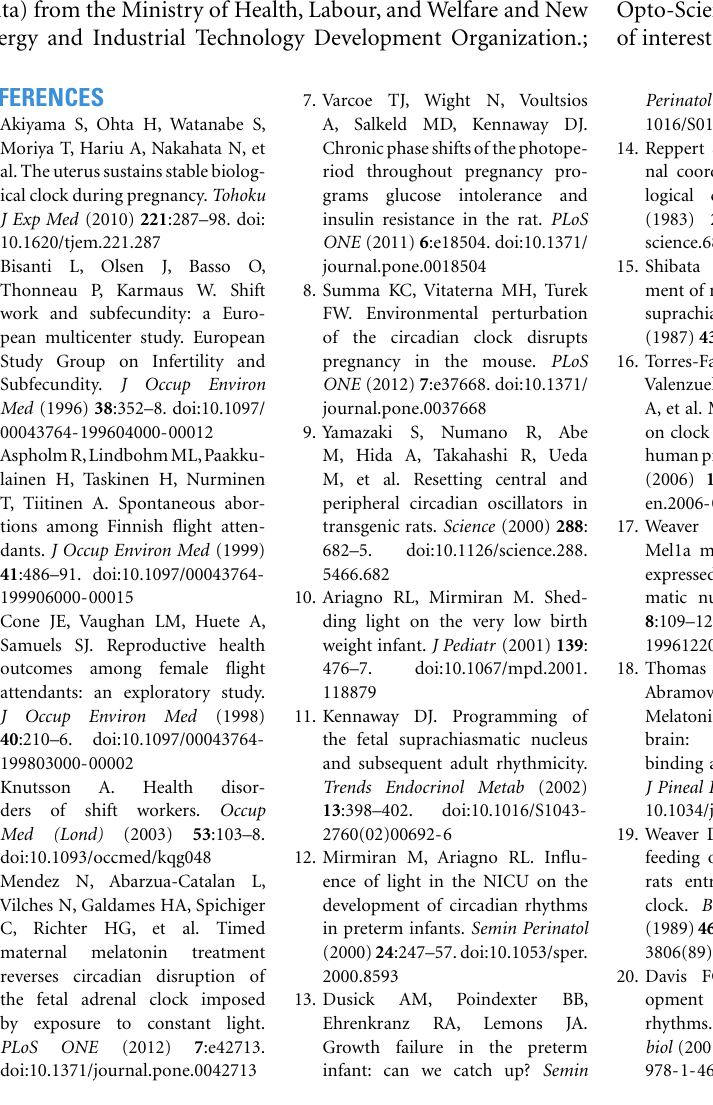
FIGURE 12 | Regression analysis of weight gain of preterm infants as a function of time .Weight gain rate was decreased with (A) filter off compared to with (B) filter on. Results are from a generalized estimated